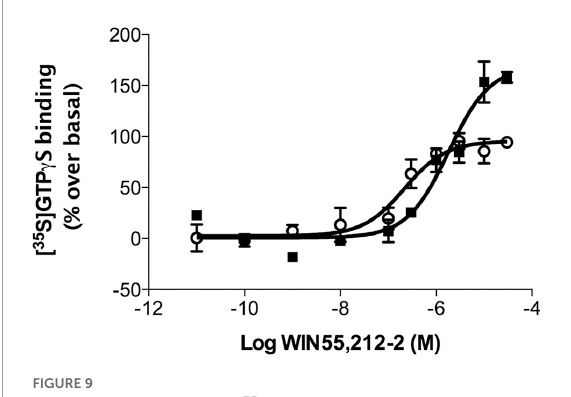
FIGURE9 WIN 55,212-2-stimulated [ 35 S]GTP γ S binding in rat brain cortical membranes obtained from medial prefrontal cortex of lean ( ◦ ) and obese ( • ) Zucker rats. Data are mean ± SEM from three different experiments performed in duplicate. Data were normalized using the Bottom and Top values of WIN55,212-2 stimulated [ 35 S]GTP γ S binding obtained in lean Zucker rats.